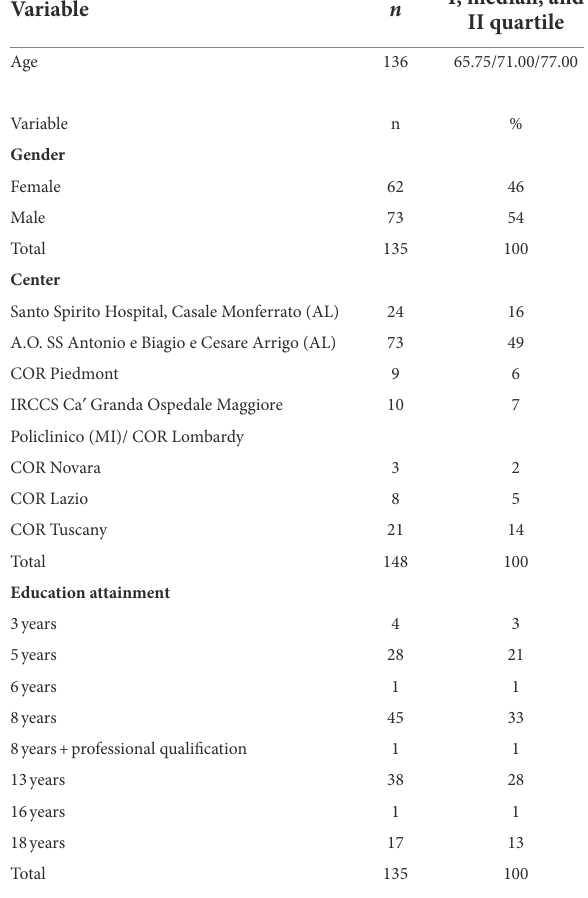
TABLE 1 Patient details. Continuous variables are synthesized in terms of first, median, and second quartile; categorical variables are reported in terms of absolute and relative frequencies.